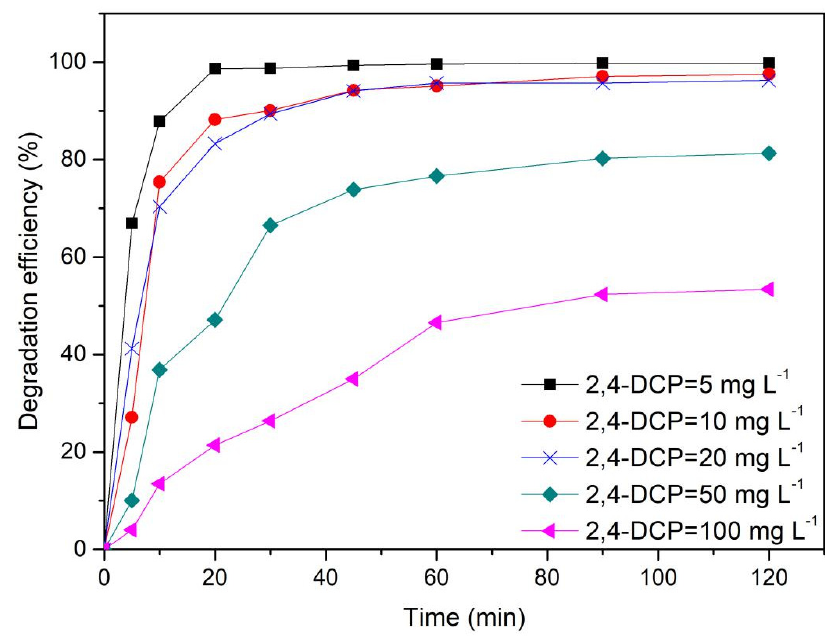
Figure 2. 2,4-DCP degradation efficiency for different 2,4-DCP initial concentrations. [Fe(III)-EDDS] = 0.1 mM, [H 2 O 2 ] = 1.0 mM, and pH = 7.0 ± 0.1. The toxicity of CPs can be ascribed to the number of Cl atoms on the benzene ring: the more Cl atoms in the chemical formula of CPs, the more toxic organic compounds there are [28]. Moreover, the quantity of Cl atoms on the benzene ring may affect the rate of degradation. Accordingly, we experimentally investigated the degradation of single 2,4,6-TCP and 2,4-DCP, as well as that of a mixture of these two pollutants. In our photo-Fenton system and the single-substance experiments, the rate of 2,4- DCP pollutant removal was superior by around 65% to those of 2,4,6-TCP (Figure 3).